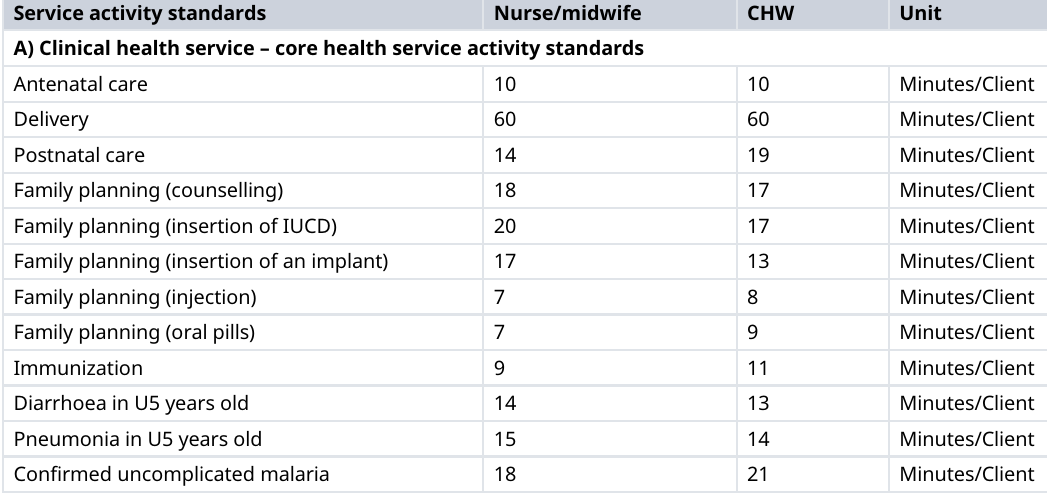
Table 1. Clinical and non-clinical workload components and service standards for primary level of